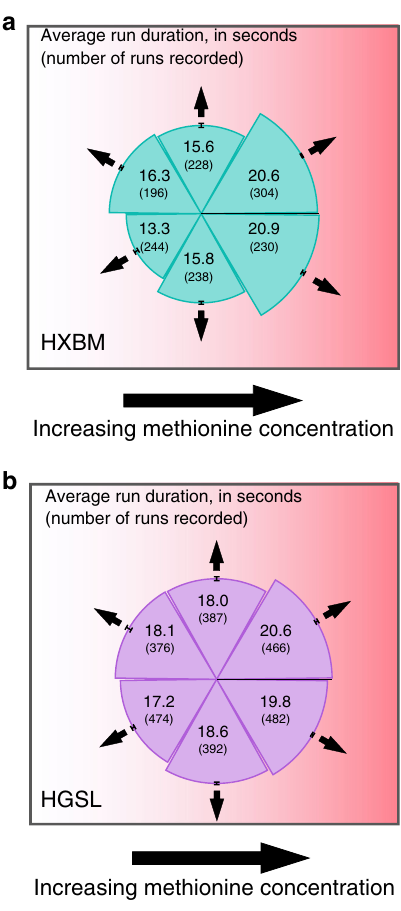
Fig. 4 Experiments demonstrating chemotactic performance. a Experimental results for Haloferax sp. Boulby Mine (HXBM) moving towards methionine. The sections of the graph show the average run duration in directions relative to the methionine gradient, with the number of runs recorded in parentheses. Error bars on each segment represent s.e.m. (standard error of the mean). b Equivalent experimental results for run duration in Haloarcula sp. Great Salt Lake (HGSL).